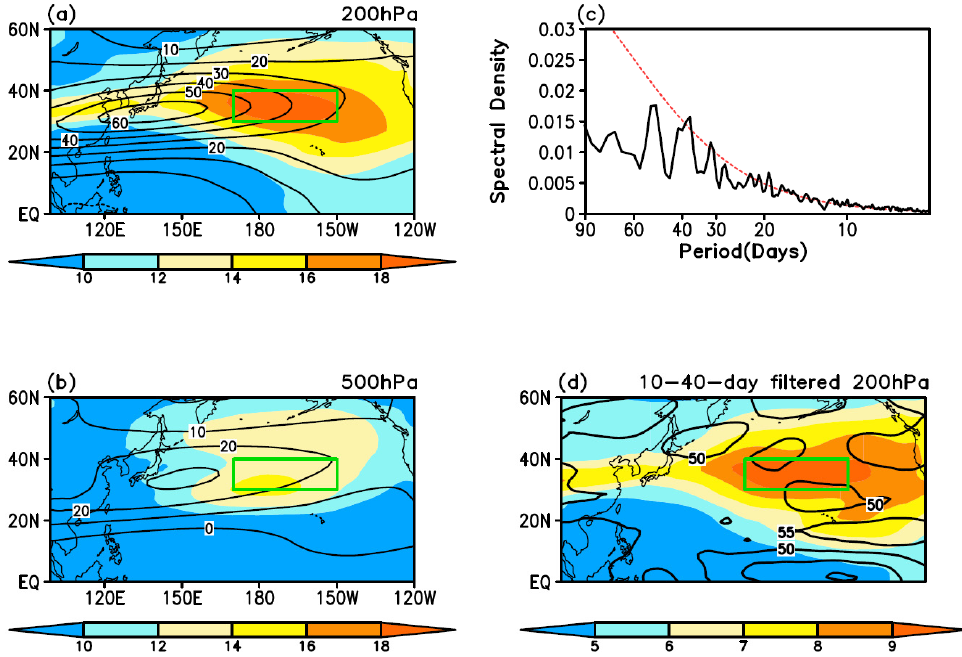
Figure 1. The mean zonal wind (contour, unit: m/s) and its mean square deviation (color shades, unit: m/s) in winter (( a ): 200 hPa, ( b ): 500 hPa), power spectrum analysis of the zonal wind in the exit region at 200 hPa ( c ), the mean square deviation of intraseasonal zonal wind (color shades, unit: m/s) and the total variances explained by the ISO (contour, unit: %) at 200 hPa ( d ). The green box represents the jet exit region (170° E–150° W, 30° N–40° N), the red dashed line the 95% red noise test, and the black solid line the power spectral density.